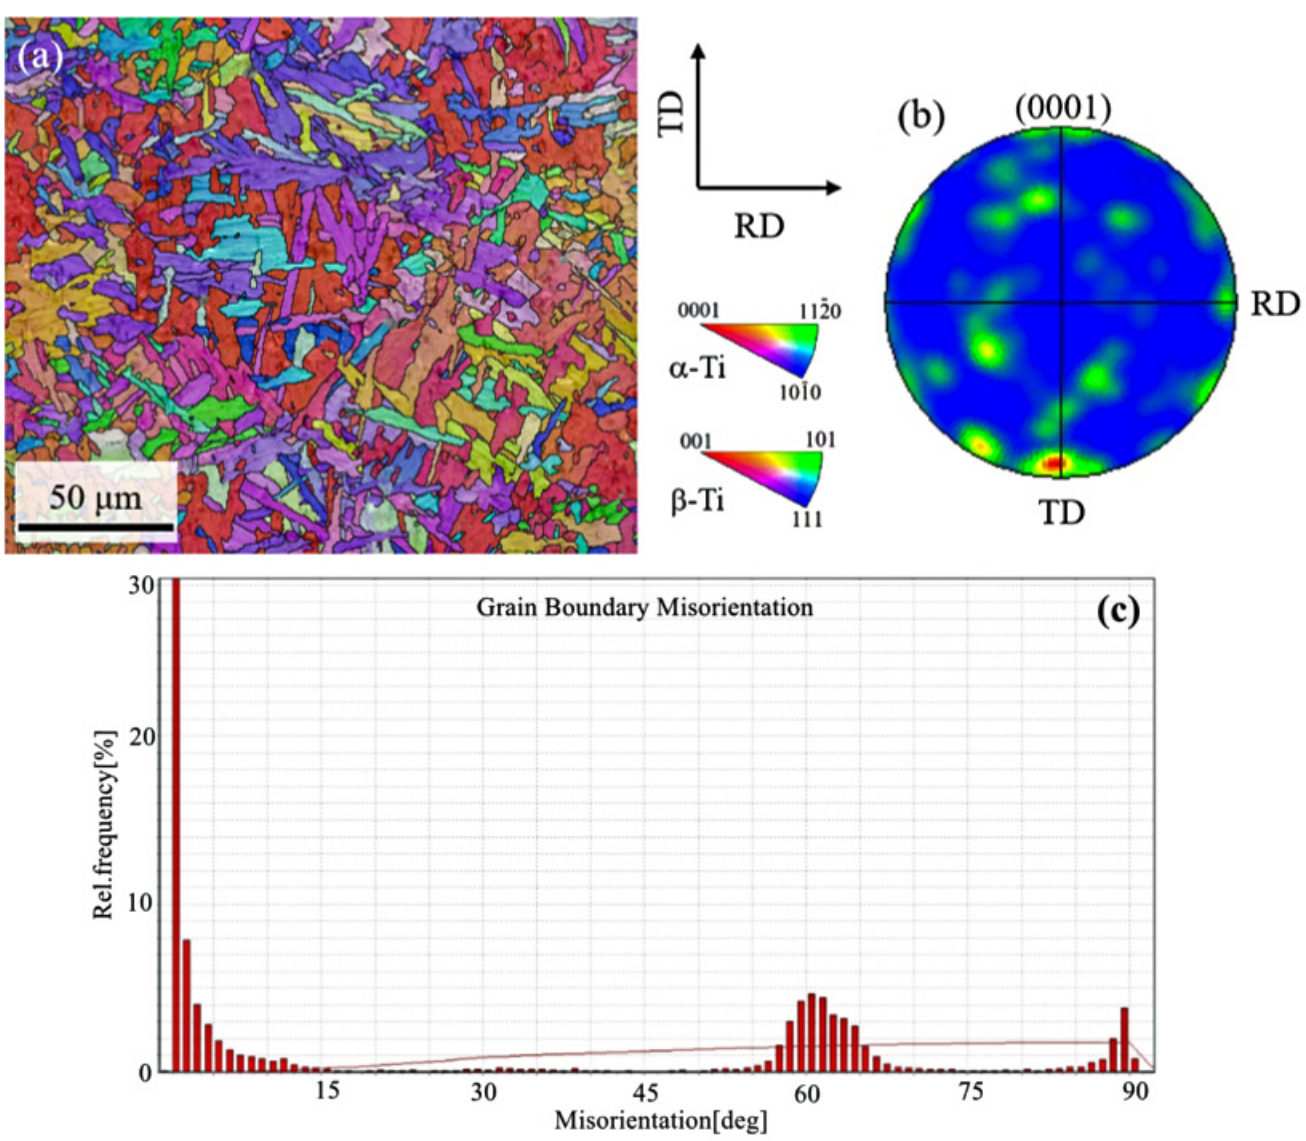
Figure 3. ( a ) Inverse pole figure along the transverse direction; ( b ) Pole figure and ( c ) grain boundary misorientation distribution of the heat-treated